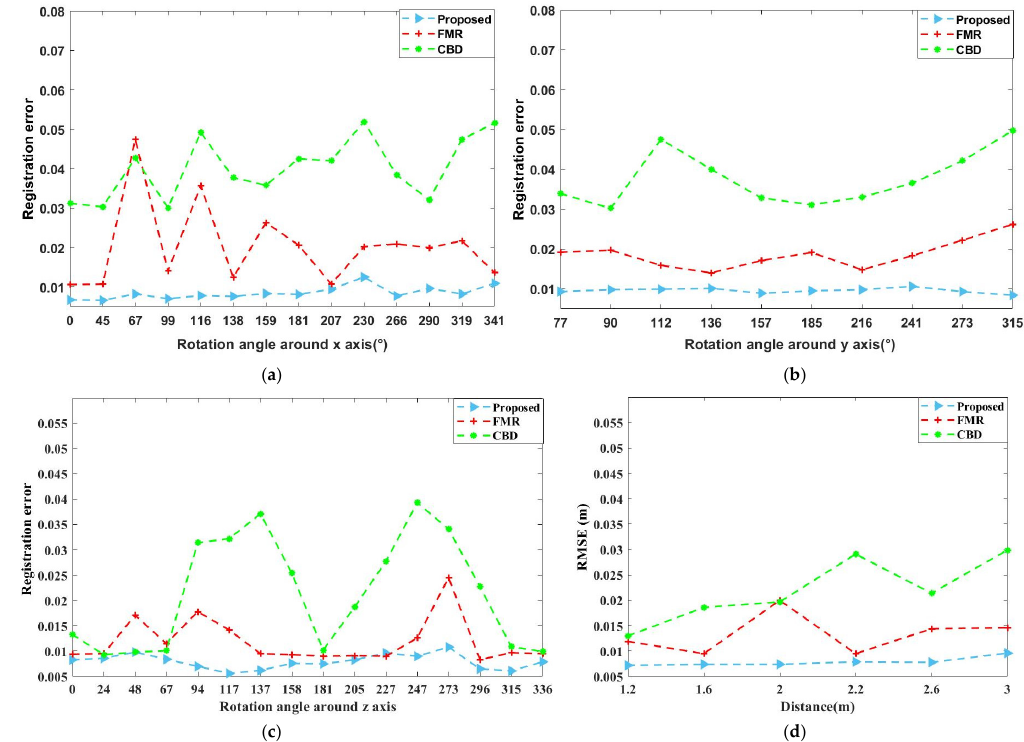
Figure 10. ( a – c ) When rotating around the x axis, y axis, and z axis, real point cloud fusion error for different rotation angles. ( d ) RMSE change curve for registration at different distances.